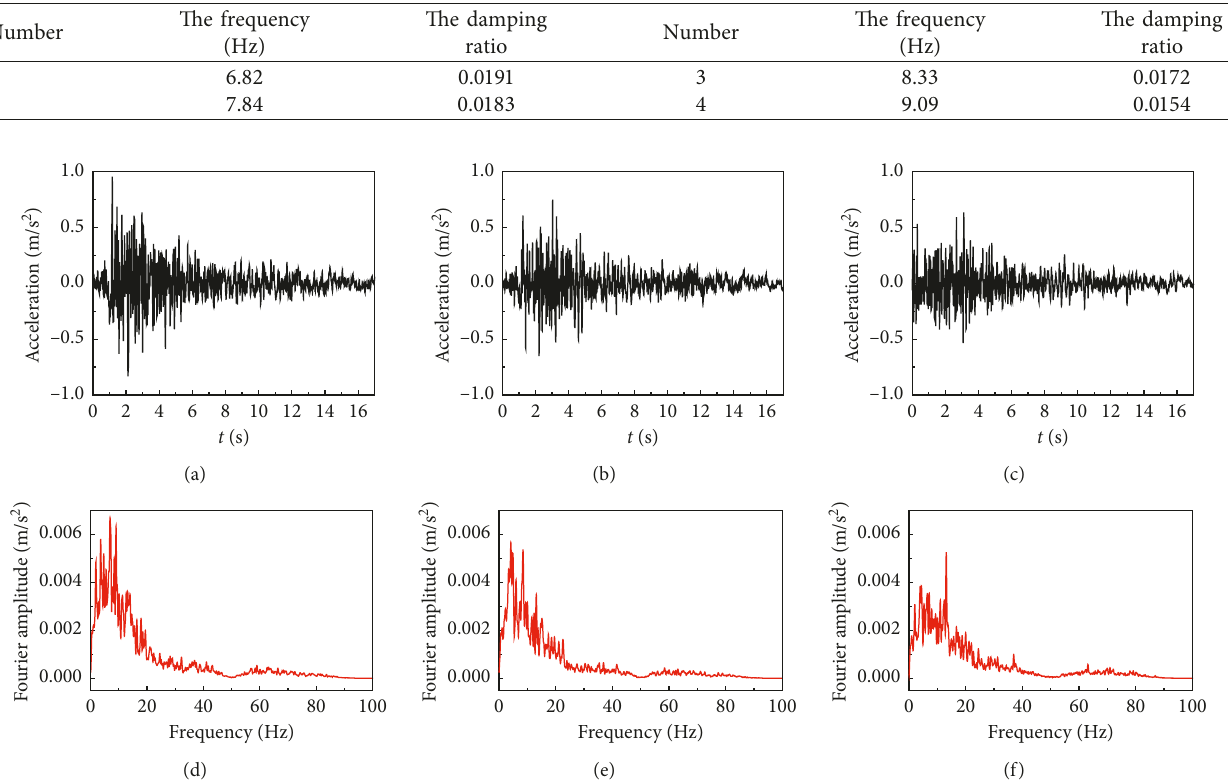
Table 6: Fourth stage of natural frequency and damping ratio of structure B2 before inputting seismic motion.